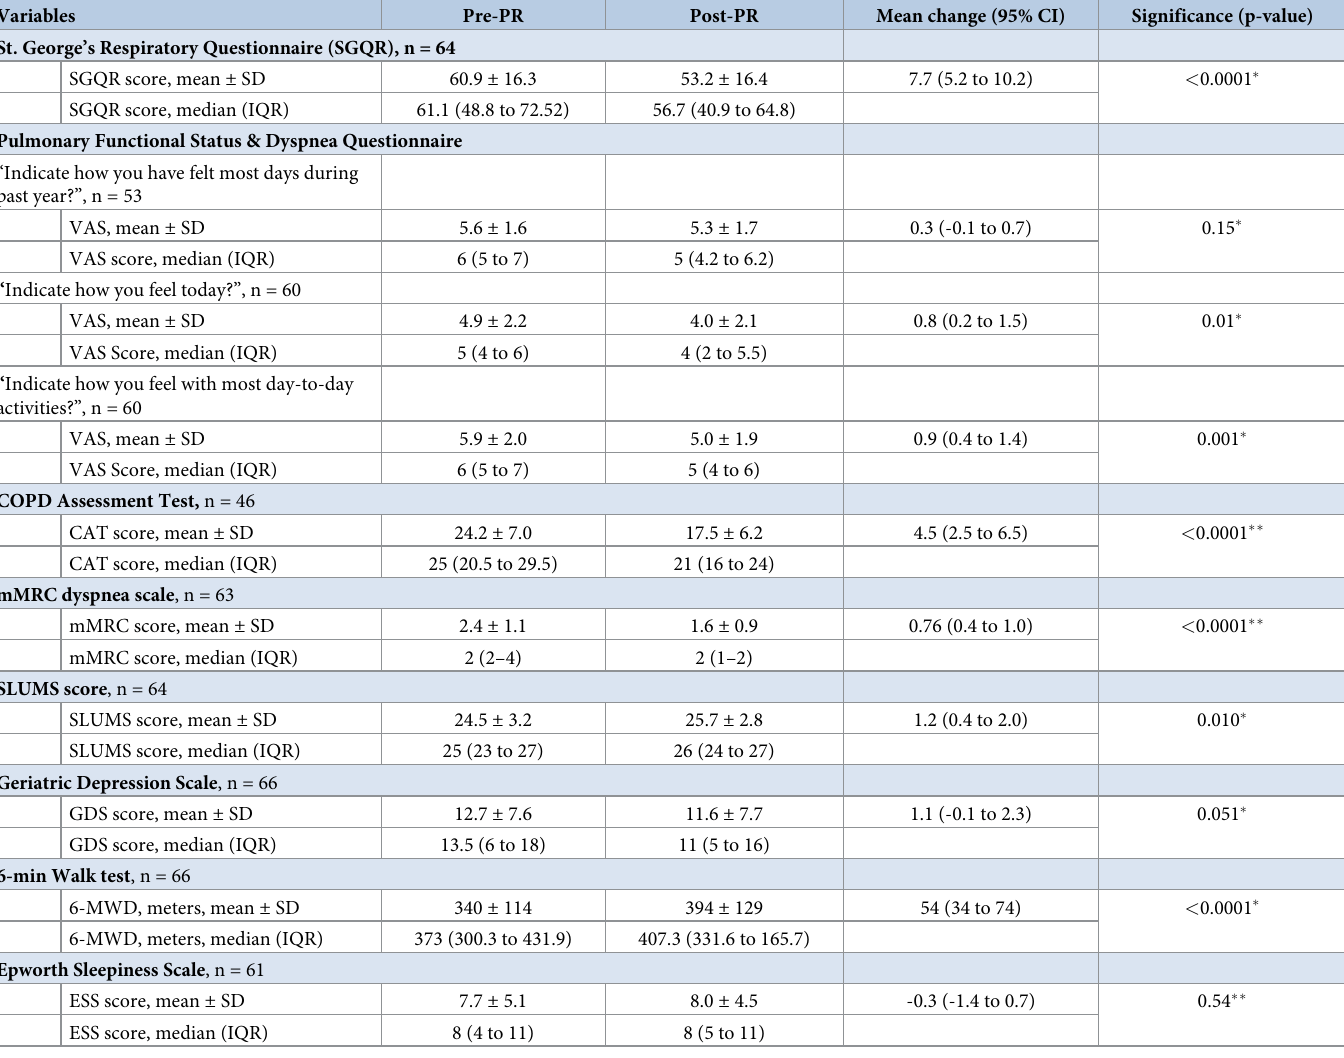
Table 2. Effect of PR on COPD/respiratory, sleep and neurocognitive variables. Variables Pre-PR